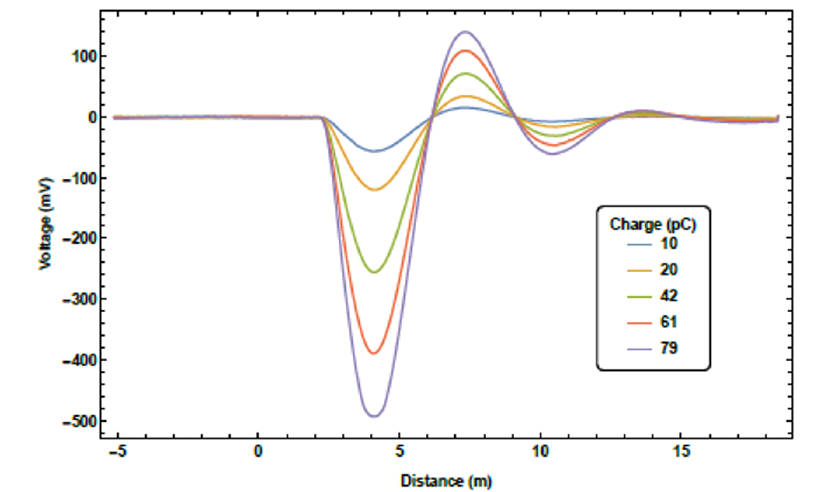
Figure 7. The Cherenkov signal as a result of beam loss for different bunch charges for a single optical fibre.